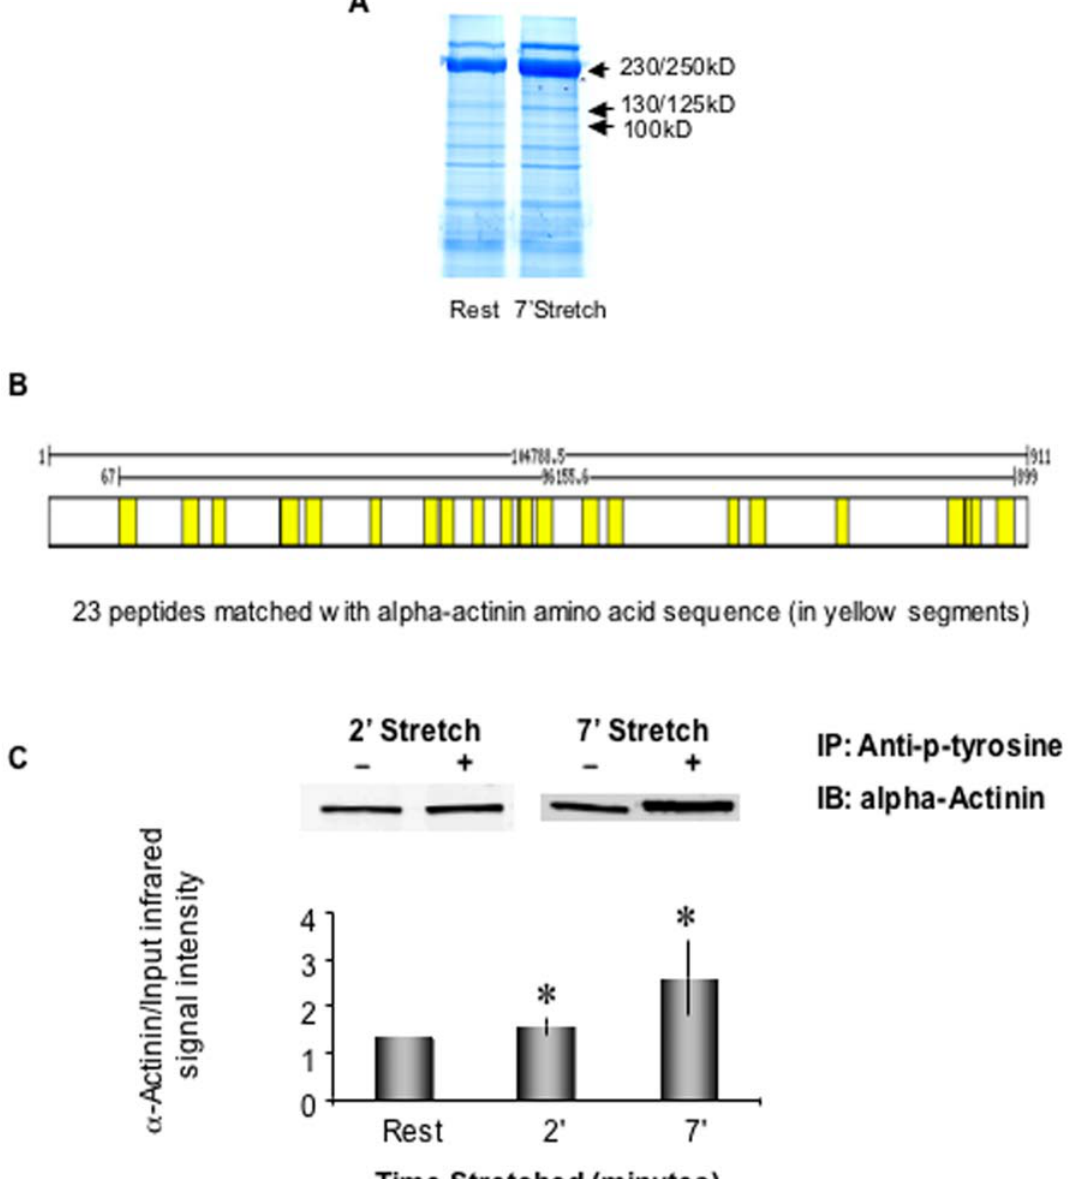
Figure 6. Identification of 100 KD protein tyrosine-phosphorylation in response to myometrial stretch. A. Stretch-induced tyrosine phosphorylation in human myometrium. Term pregnant uterine smooth muscle strips unstretched or stretched to 2x slack length for 7 min. Coomassie blue staining of anti-phosphotyrosine immunoprecipitates separated by 10% SDS-polyacrylamide gel electrophoresis (n=2). B. Mass spectrometric identification of the 100 kD band. The protein band was excised from the gel. There is a 281/911 (31%) sequence coverage with 23 peptides matched to alpha 4 actinin, (in yellow) and 19% sequence coverage with 13 peptides matched to alpha 1 actinin (not shown). C. Alpha actinin is tyrosine phosphorylated by stretch in human myometrium. Homogenates of stretched and unstretched term pregnant human uterine smooth muscle were immunoprecipitated (IP) with an anti-phospho-tyrosine antibody and western immunoblotted (IB) with an alpha-actinin antibody. The graph shows the average densitometry from 5 independent experiments. The inserts are typical western blots of immunoprecipitates. *p , 0.05 compared to unstretched control samples.